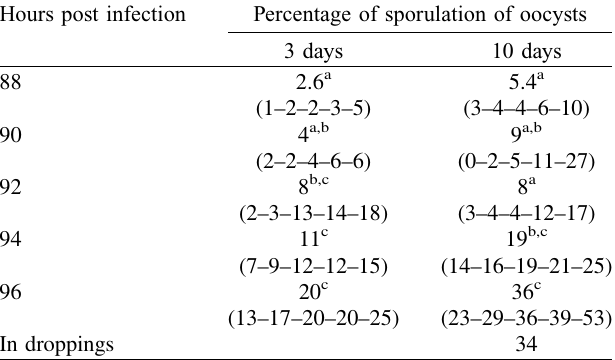
Table 1. Third study with E. acervulina – evolution of the percentage of sporulation of oocysts of E. acervulina (PA3 strain) collected in the duodenum every two hours from 88 to 96 h after infection. One hundred oocysts were observed for each sample. Each value is the mean value of fi ve birds (corresponding individual values are between parentheses). Percentage of sporulation was evaluated after incubation for 3 or 10 days at 28 (cid:3) C. The percentage of sporulation of oocysts collected in droppings is given in the last line of the table. Different letters in superscript in a same column mean statistically signi fi cant differences (Kruskal – Wallis test fol- lowed by Mann – Whitney